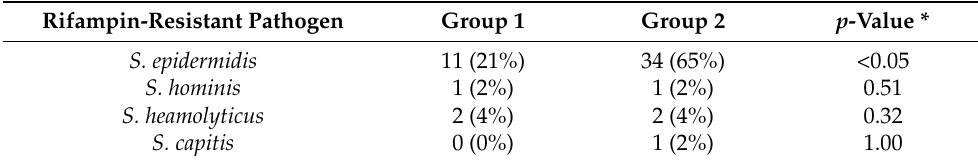
Table 2. Identified rifampin-resistant